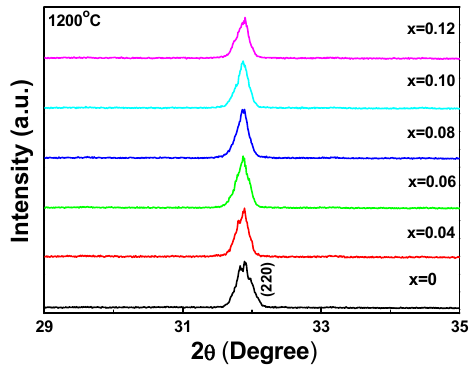
Figure 2. XRD patterns of Sr 2 − x Eu x ZnMoO 6 phosphors synthesized at 1200 °C for 4 h.